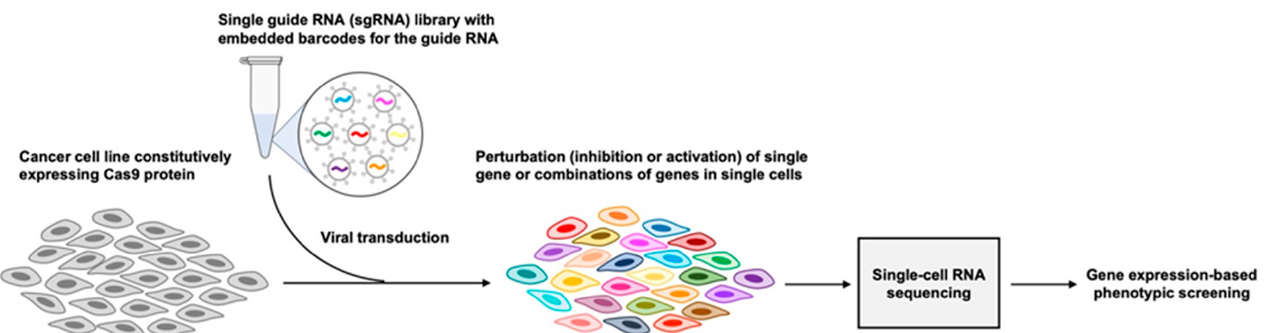
Figure 3. Schematic of high-throughput genetic screening using clustered regularly interspaced short palindromic repeats (CRISPR)-based perturbations and single-cell RNA sequencing. Tumor cell lines that constitutively express the Cas9 protein are infected with lentiviruses that each contain (1) a single guide RNA (sgRNA) specific for a single gene, and (2) a unique oligonucleotide barcode specific for the sgRNA. In the context of a CRISPR-i or CRISPR-a screen, the Cas9 protein expressed by the cell line has been modified to inhibit or activate transcription, respectively. In this context, the sgRNAs target the regulatory regions of genes. In the context of a gene knockout screen, however, the Cas9 protein expressed by the cell line cleaves the genomic region targeted by the sgRNA, rendering the targeted gene inactive. Following the CRISPR-based perturbation, cells can be further manipulated (e.g., treated with a drug) after which they undergo single-cell RNA sequencing. Using the sgRNA-specific and cell-specific bar- codes, the expression profile associated with each perturbation can then be delineated.